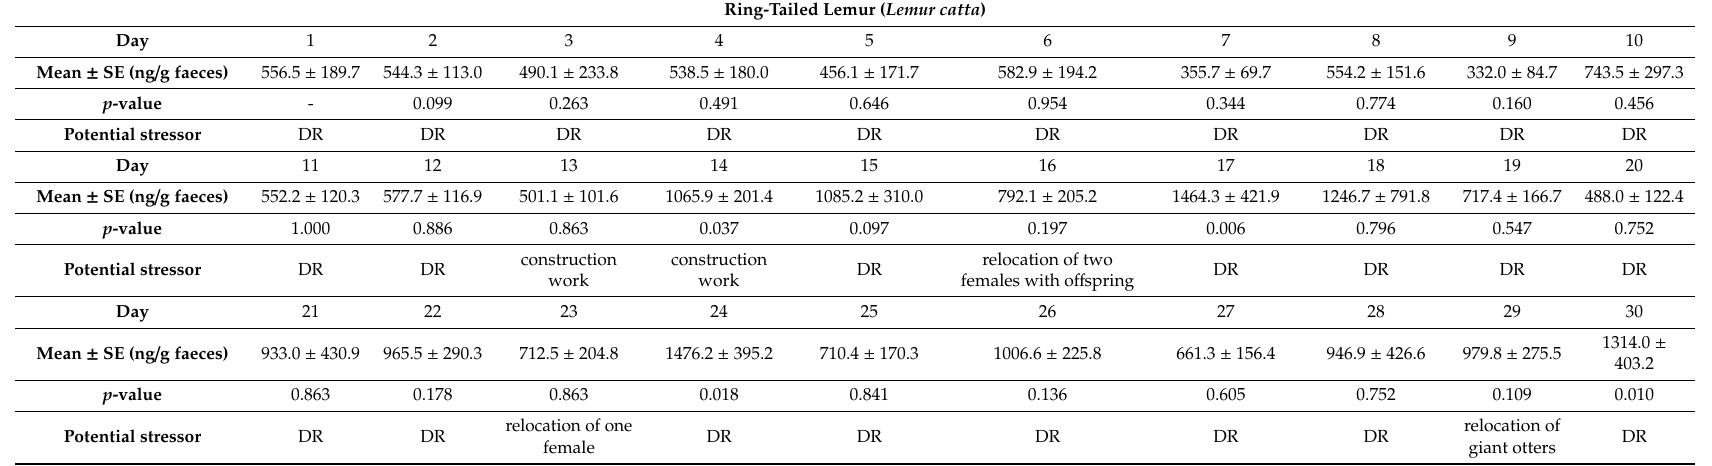
Table 2. Mean concentrations of the faecal glucocorticoid metabolites (FGMs) in ring-tailed lemurs and potentially stressful events for each day of monitoring. Ring-Tailed Lemur ( Lemur catta